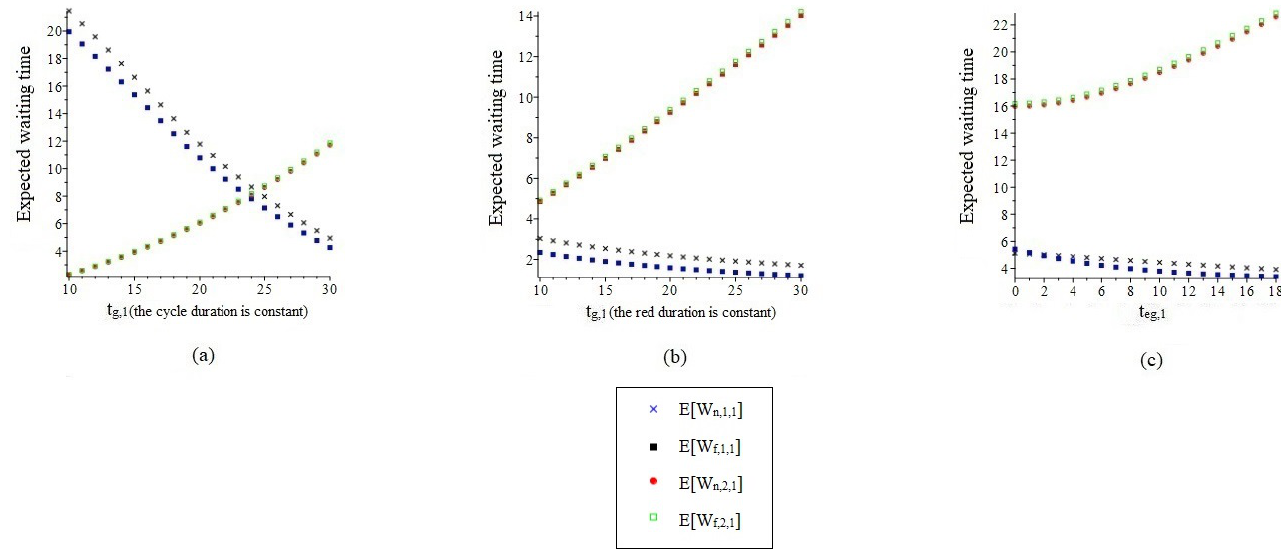
Figure 6. Expected waiting times as functions of ( a ) green time when the cycle time is constant, ( b ) of green time when the red time is constant and ( c ) of green extension